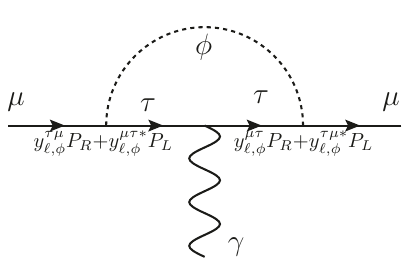
Figure 7. The Y (cid:28)(cid:22)